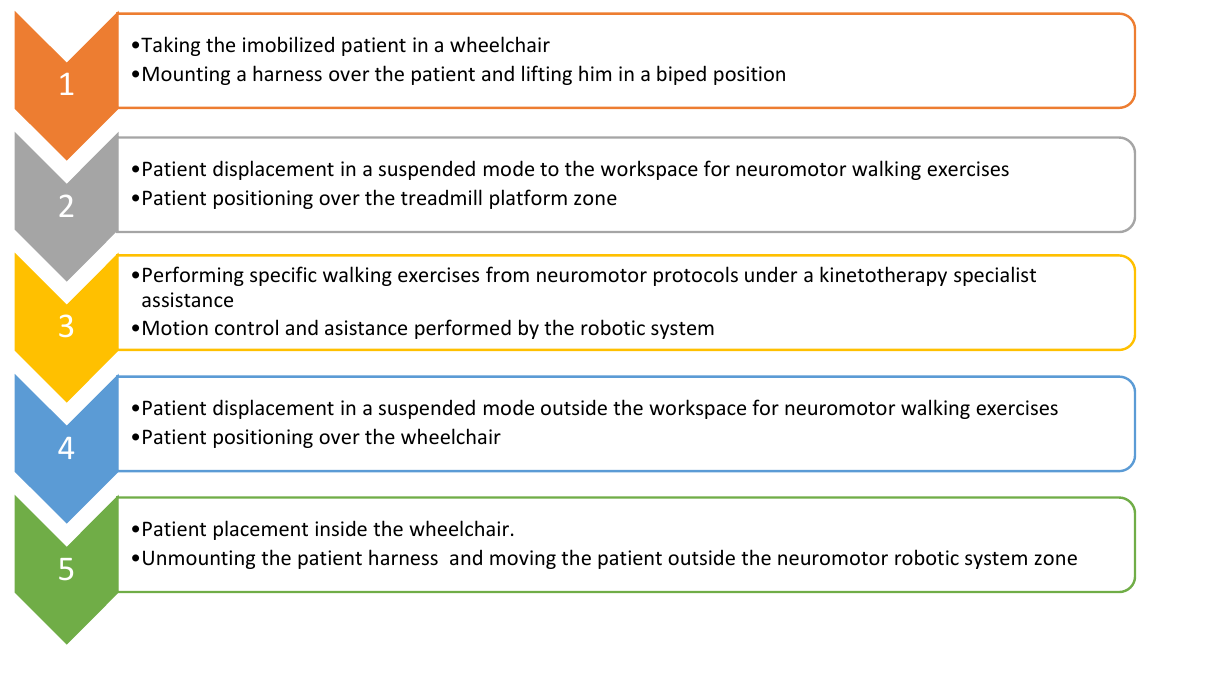
Figure 21. Desired functions procedure which will be assured by the desired exoskeleton prototype.